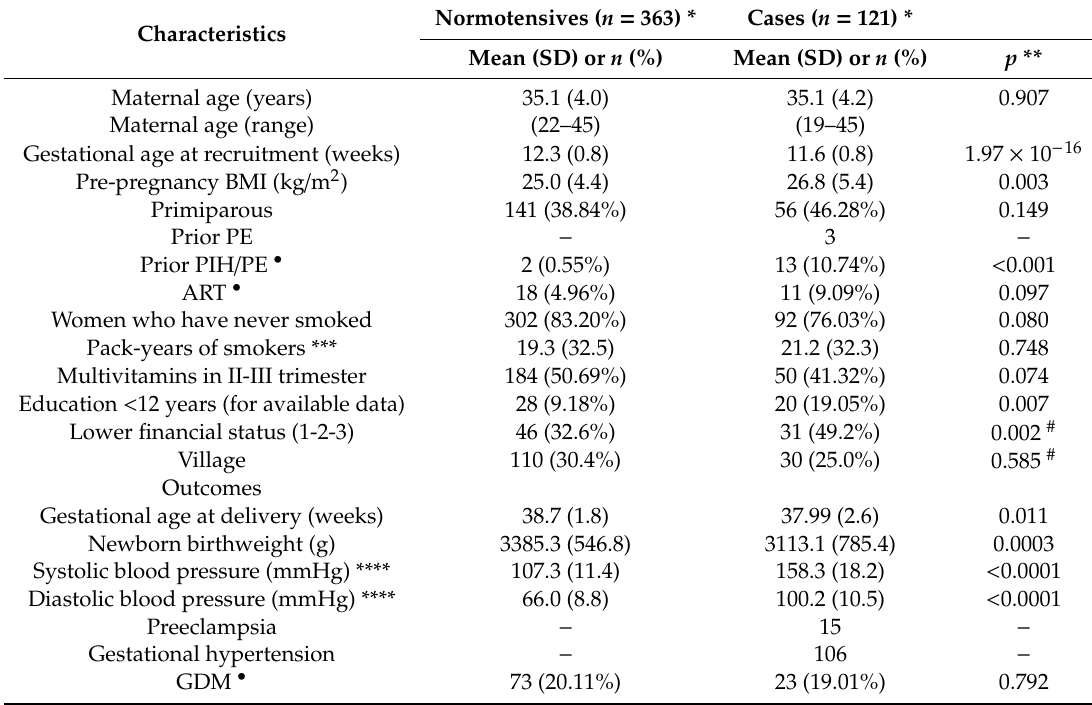
Table1. The clinical characteristics of the normotensive controls and cases of pregnancy-induced